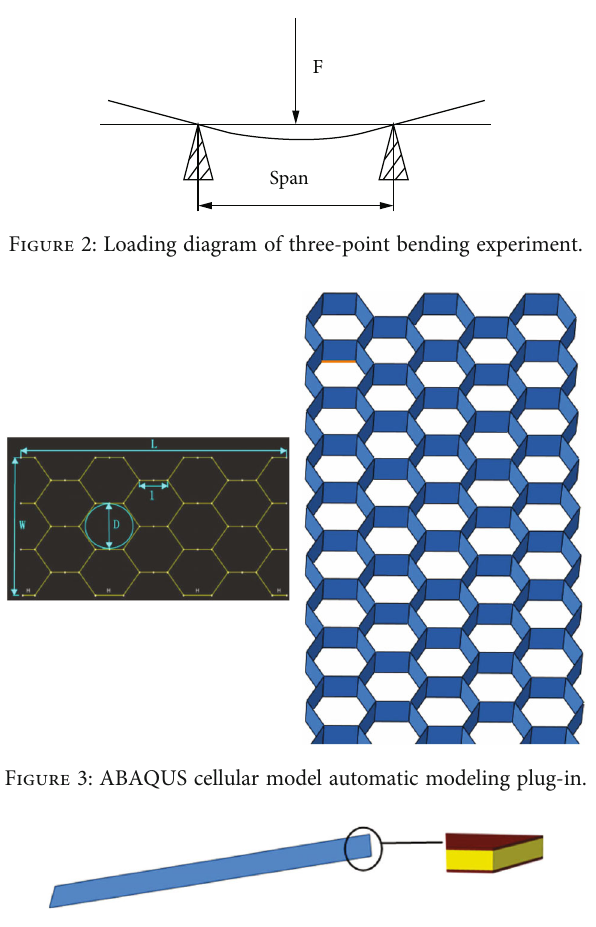
Figure 4: Equivalent sandwich model of honeycomb sandwich panel.